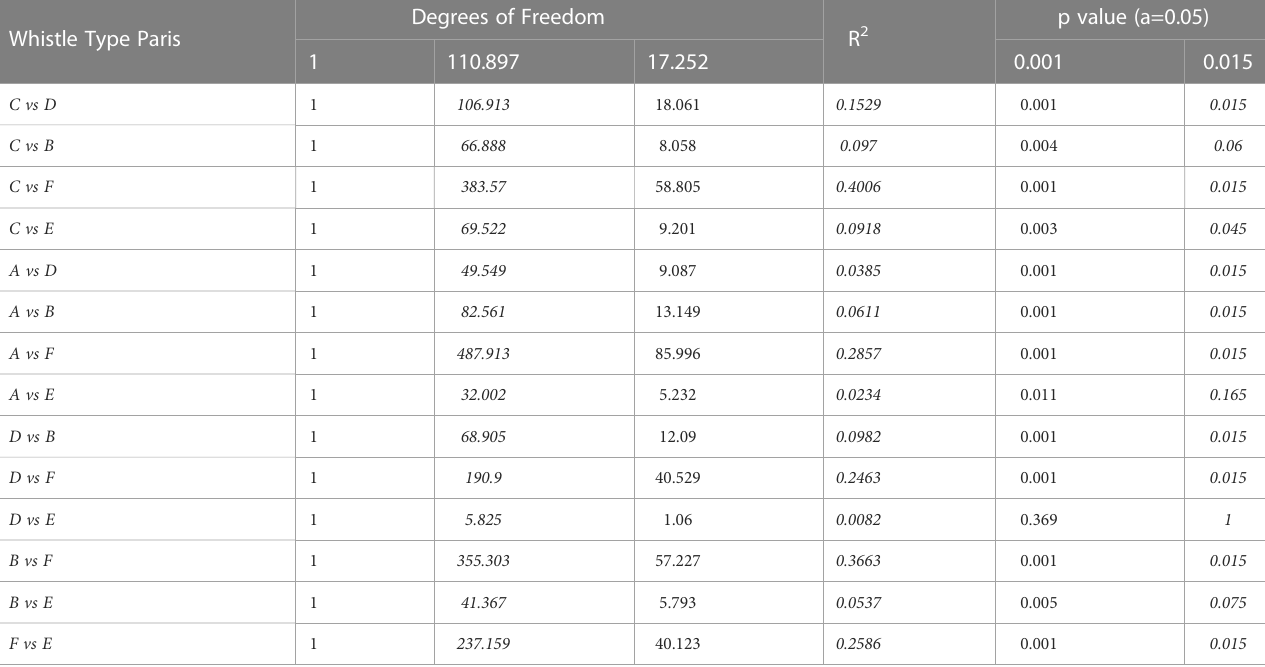
TABLE 4 Post hoc pairwise Adonis testing of the whistle types based on euclidean distances with 999 permutations and Bonferroni adjustments to the signi fi cance level.